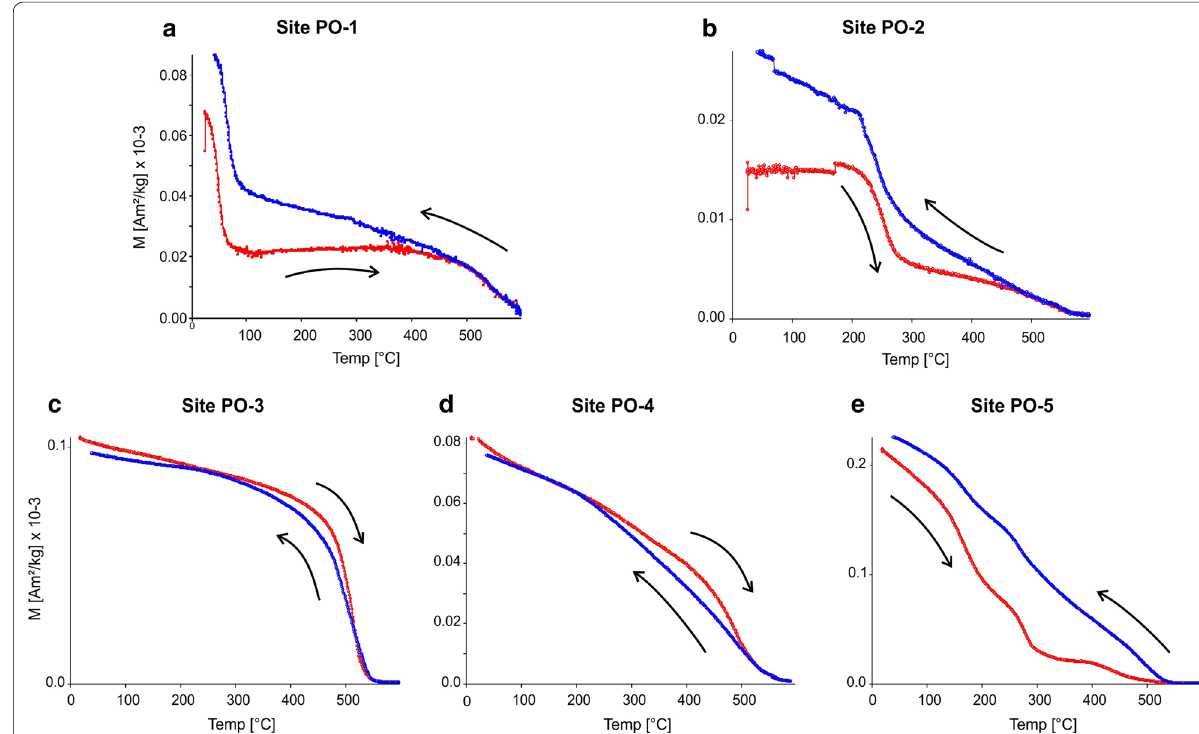
Fig. 11 High‑field‑induced magnetization versus temperature (M–T) plots for the two scorias of the two PDCs ( a , b ) and the three lavas ( c – e )